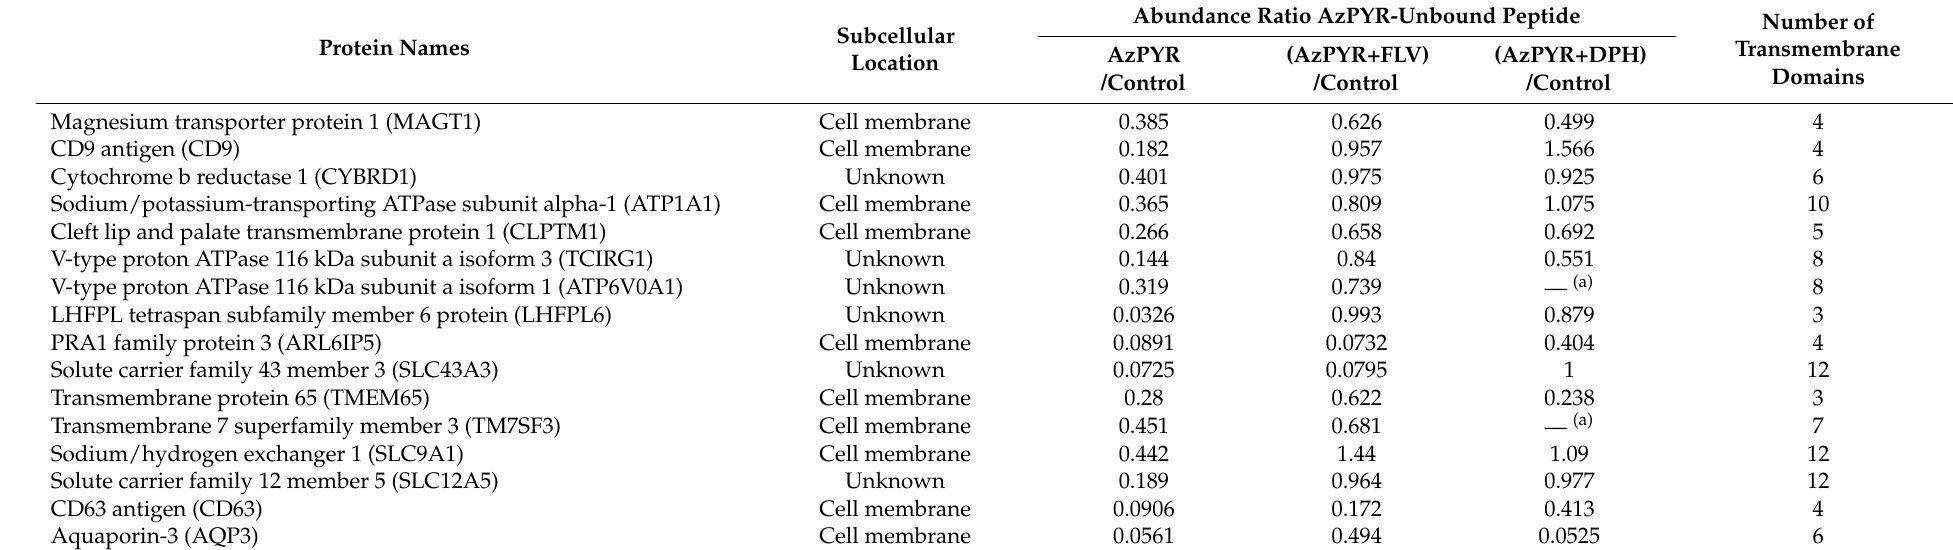
Table 1. Sixteen proteins selected as H + /OC antiporter